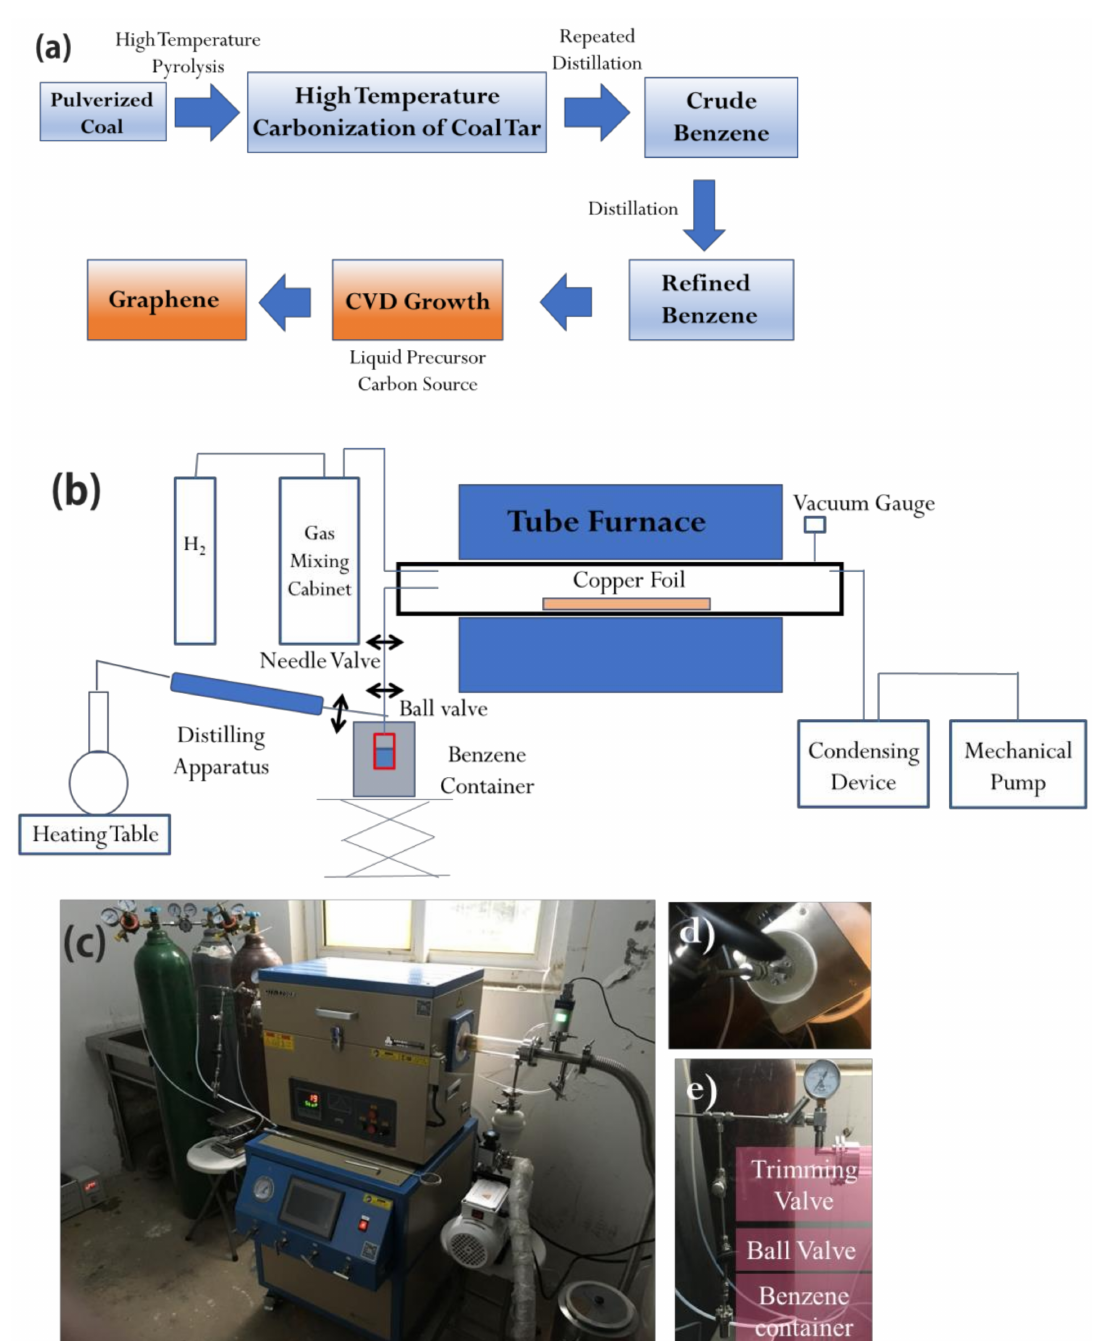
Figure 4. ( a ) Preparation process of graphene with coal as carbon source; ( b ) schematic diagram of the device for preparing graphene from the benzene; ( c ) the photo of the instrument; ( d ) the photo of the benzene container immersed in liquid nitrogen to solidate the benzene inside; ( e ) the photo of the device for controlling the benzene flow